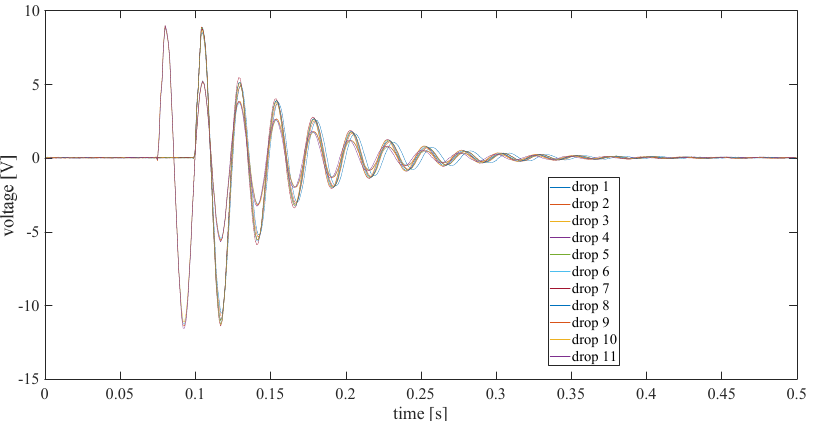
Figure 7. Voltage obtained at the ends of the structures due to a raindrop falling from 0.5 m and hitting the free edge.